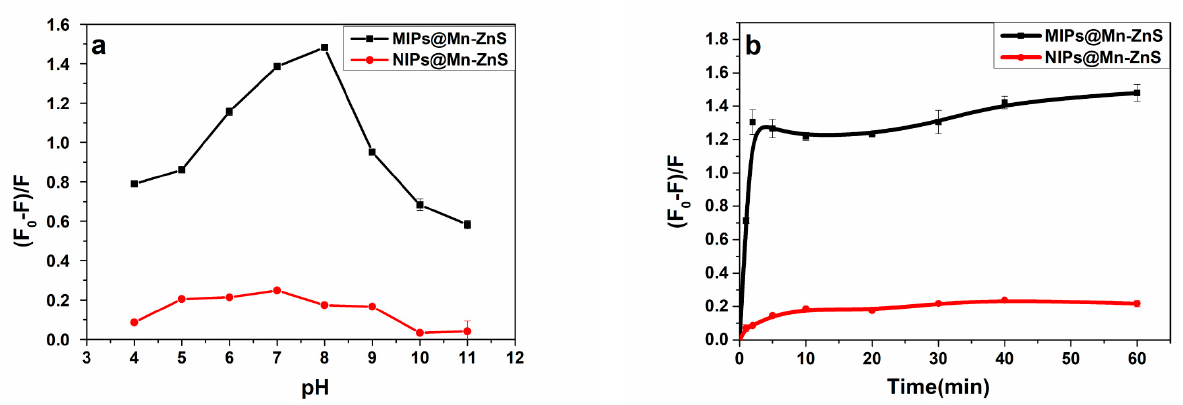
Figure 5. ( a ) The pH-dependent fluorescent quenching ratios changes of MIPs@Mn-ZnS QDs and NIPs@Mn-ZnS QDs in the presence of 2.5 μ M ROX. ( b ) The effect of